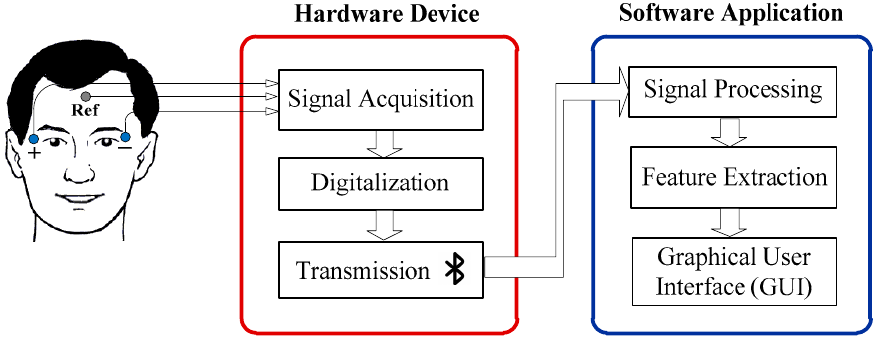
Figure 4. Flow diagram of the main tasks implemented for ataxia evaluation.